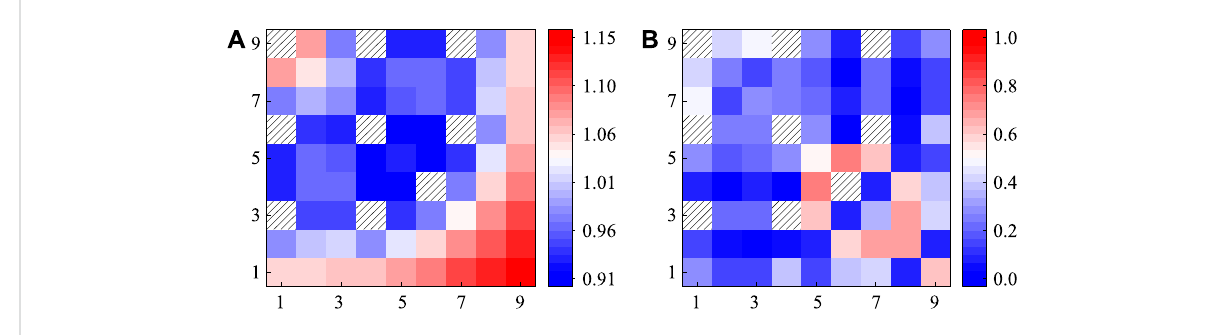
FIGURE 17 Calculation results of pin power of the VERA 2F lattice: (A) referenced normalized pin power; (B) absolute value of relative deviation/%.